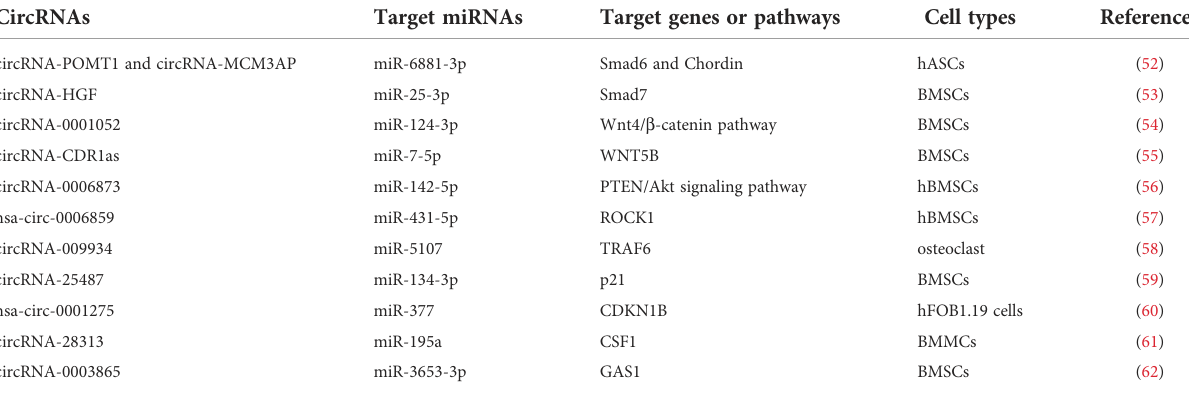
TABLE 2 The inhibitory effects of the circRNA – miRNA – mRNA axis during bone formation.